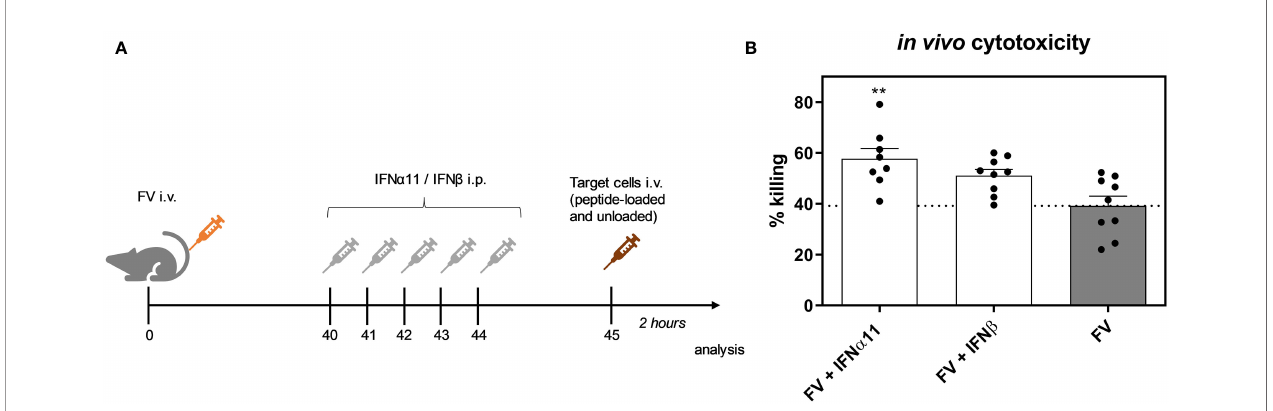
FIGURE 6 | In fl uence of IFN treatment on the cytotoxic activity of FV-speci fi c CD8 + T cells in vivo . C57BL/6 mice were infected with 20,000 SFFU of FV and additional 100,000 FFU of F-MuLV. Mice were treated daily with 8000 units of IFN a 11 or IFN b from day 40 to 44 mice. At day 45 post infection, peptide-loaded and Cell Trace ™ Violet-labeled target cells (80 µM, high) were mixed with unloaded and Cell Trace ™ Violet-labeled target cells (2 µM, low) in a ratio of 1:1 and were injected i.v. into FV-infected and IFN-treated mice. After 2 hours, mice were sacri fi ced and the killing capacity was determined. (A) The scheme of the experimental timeline is shown. (B) The percentages (+SEM) of target cell killing in spleen is shown. Statistically signi fi cant differences between the groups were tested using ordinary one way ANOVA and Tukey ’ s multiple comparison and are indicated by ** for p <